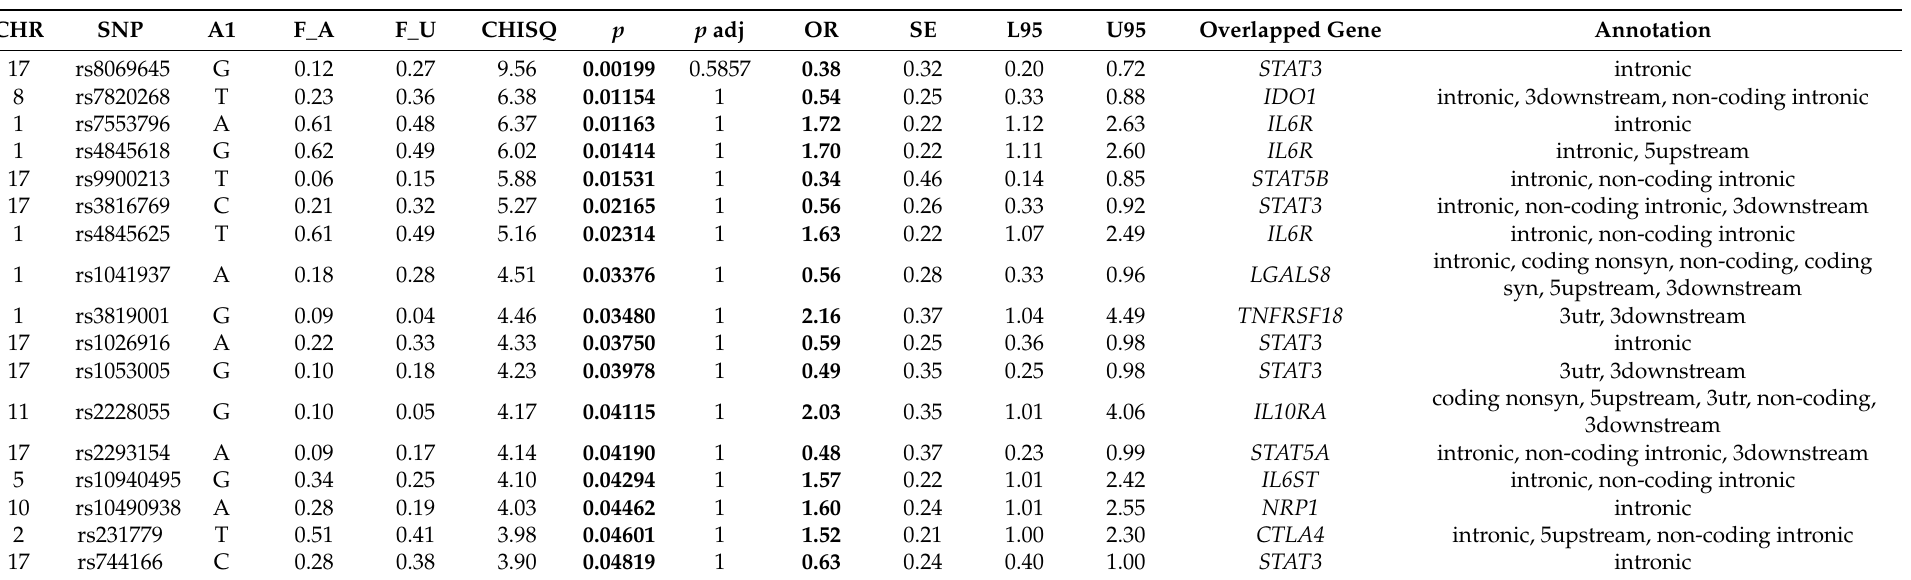
Table 3. Comparison of the frequency of SNPs in the group of patients with type II PsO and the control